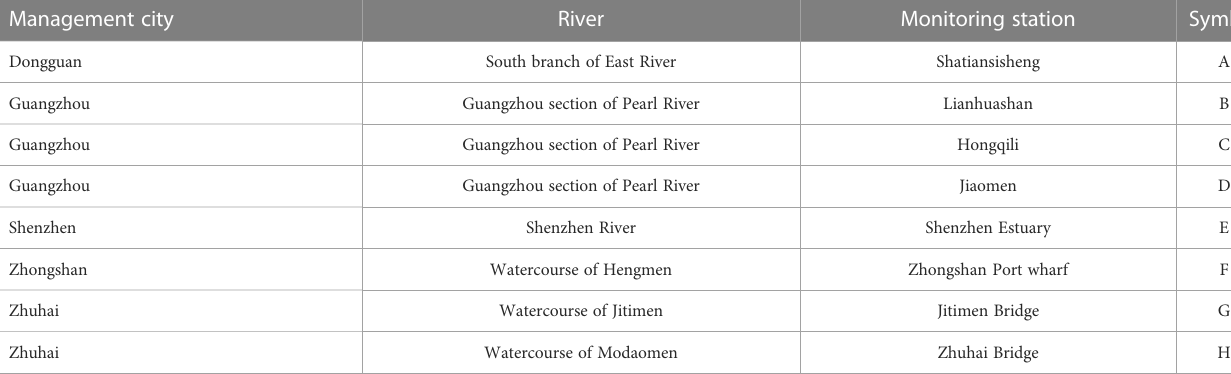
TABLE 1 Information on the rivers entering the sea fl owing into the coastal waters of the PRE. Management city